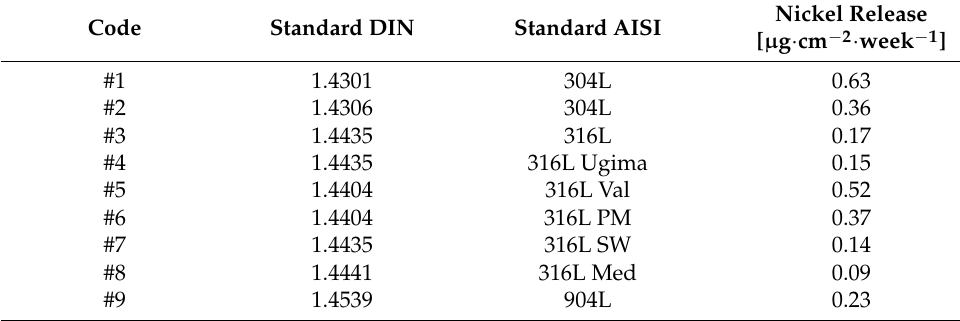
Table 3. Nickel release according to EN 1811